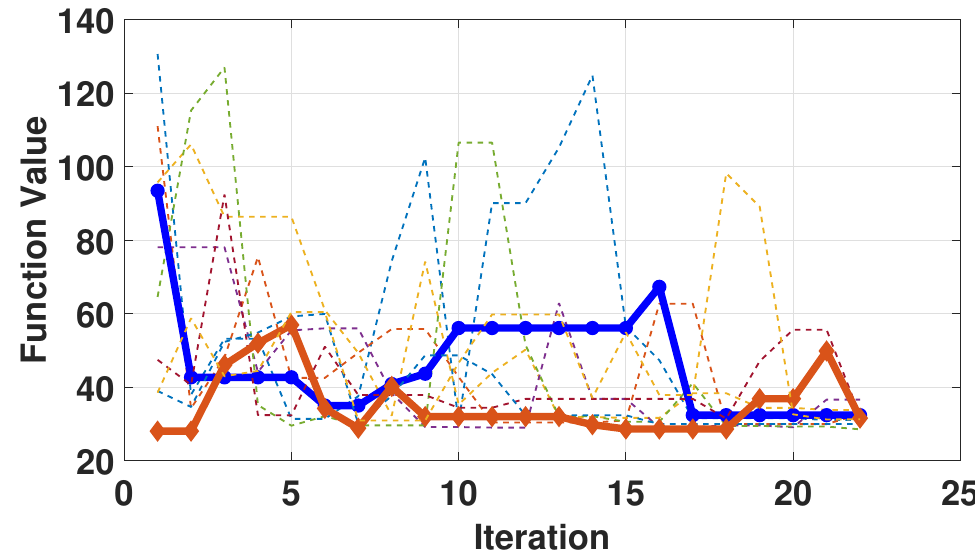
Figure 5. Iterative process of the 1D target imaging distance estimation based on simulated anneal- ing algorithm.